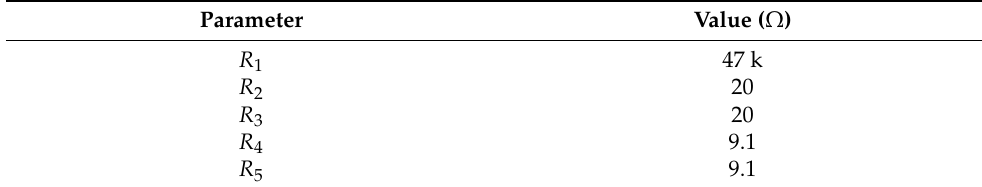
Figure 4. BPSK modulation circuit. Table 2. List of parameters of Figure 4.